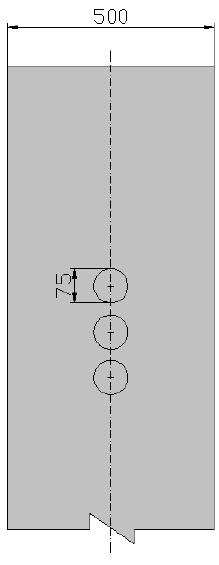
Figure 13. Sampling points (unit: mm).